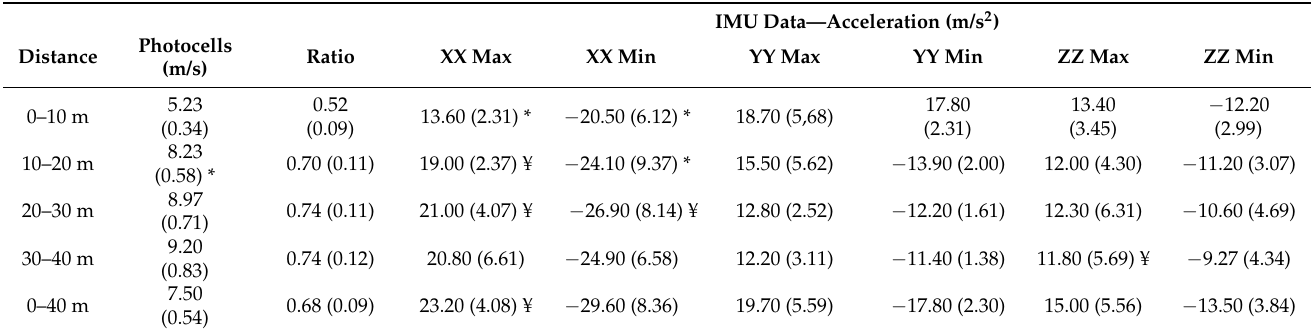
Table 3. The description (mean (SD)) and correlation analyses between the inertial measurement unit (IMU) and photocells at a distance of 0–10 m.